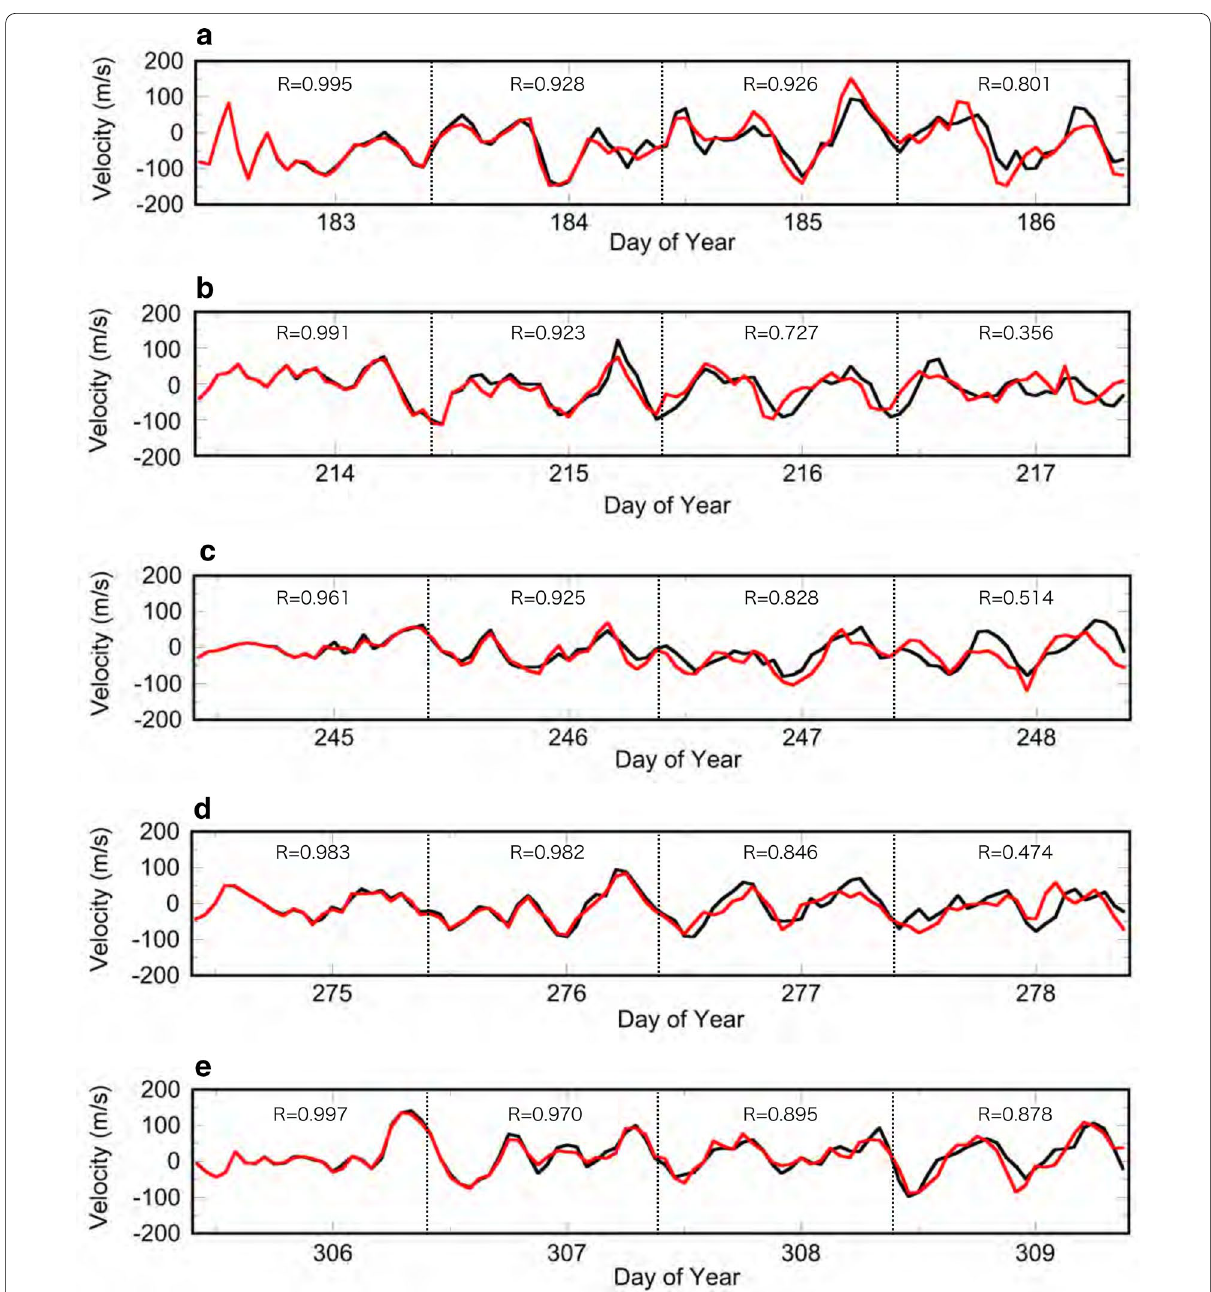
Fig. 10 Comparisons of neutral wind velocities with and without JRA-55. The eastward neutral wind velocities at 120 km with and without JRA-55 for five different periods in Okinawa 2019 are compared, starting from the same initial values at 0 UT of the first day of the 5 months in 2019: a July, b August, c September, d October, and e November. The black line and the red line indicate neutral wind velocities with and without JRA-55,